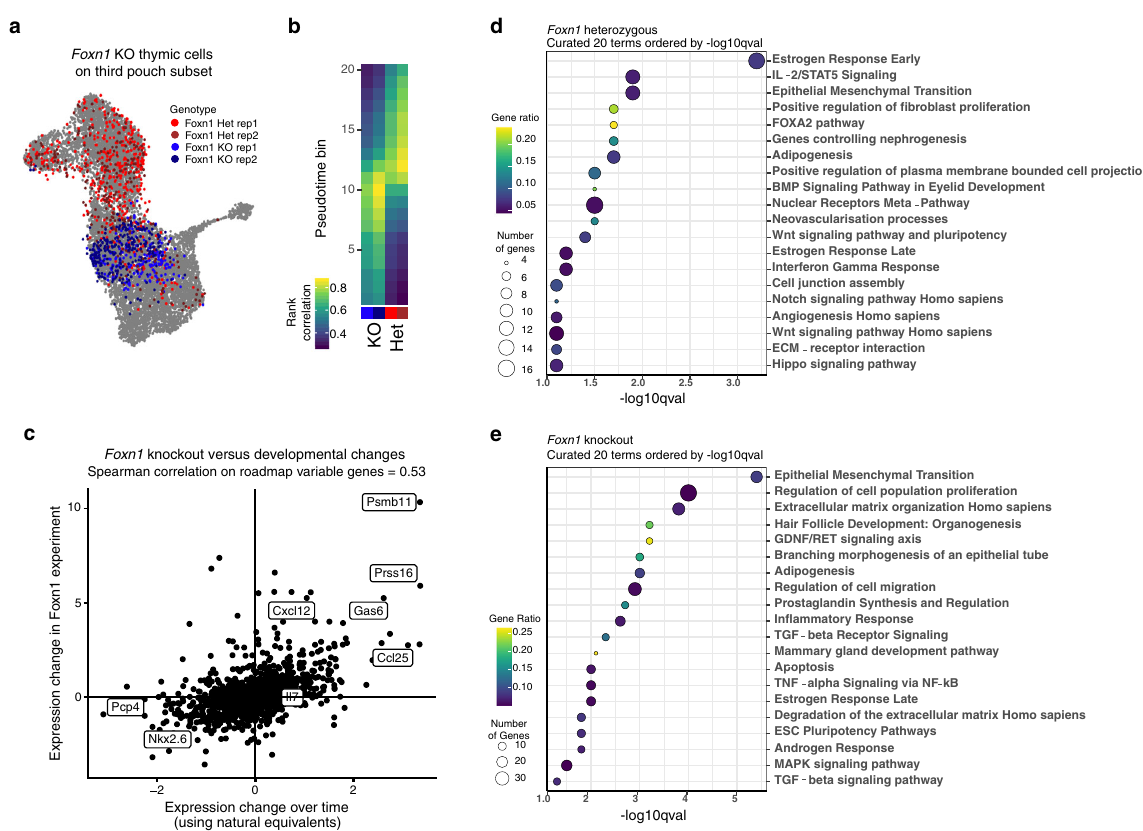
Fig. 6 Characterization of Foxn1 de fi ciency reveals underlying molecular basis for developmental block. a Projection of thymic cells from Foxn1 KO (blue) and control (red) onto the third pouch subset analysis (gray), which is described in Supplementary Fig. 11. b Spearman correlation of Foxn1 experiment samples with pharynx atlas counterparts across pseudotime. Pseudotime is as shown in Supplementary Fig. 11 (DPT rank), and each bin contains an equal number of cells. Non-thymic cells from both datasets were omitted from this analysis. c Gene-by-gene comparison of Foxn1 KO effects with “ developmental block ” model. Each dot represents one gene. Vertical axis shows log2-fold change between Foxn1 KO and control. Horizontal axis shows log2-fold change in normalized expression between the scRNA atlas cells best correlated with the Foxn1 KO (pseudotime bins 9 – 10) and with the control (pseudotime bins 12 – 13). d , e EnrichR analysis of genes differentially expressed between the control and Foxn1 KO thymic cells. Dotplots contain curated lists of 20 terms enriched in the control ( d ) and Foxn1 KO ( e ) thymus. Genes were selected based on a cutoff of log2-fold change > 0.5 and q -value <